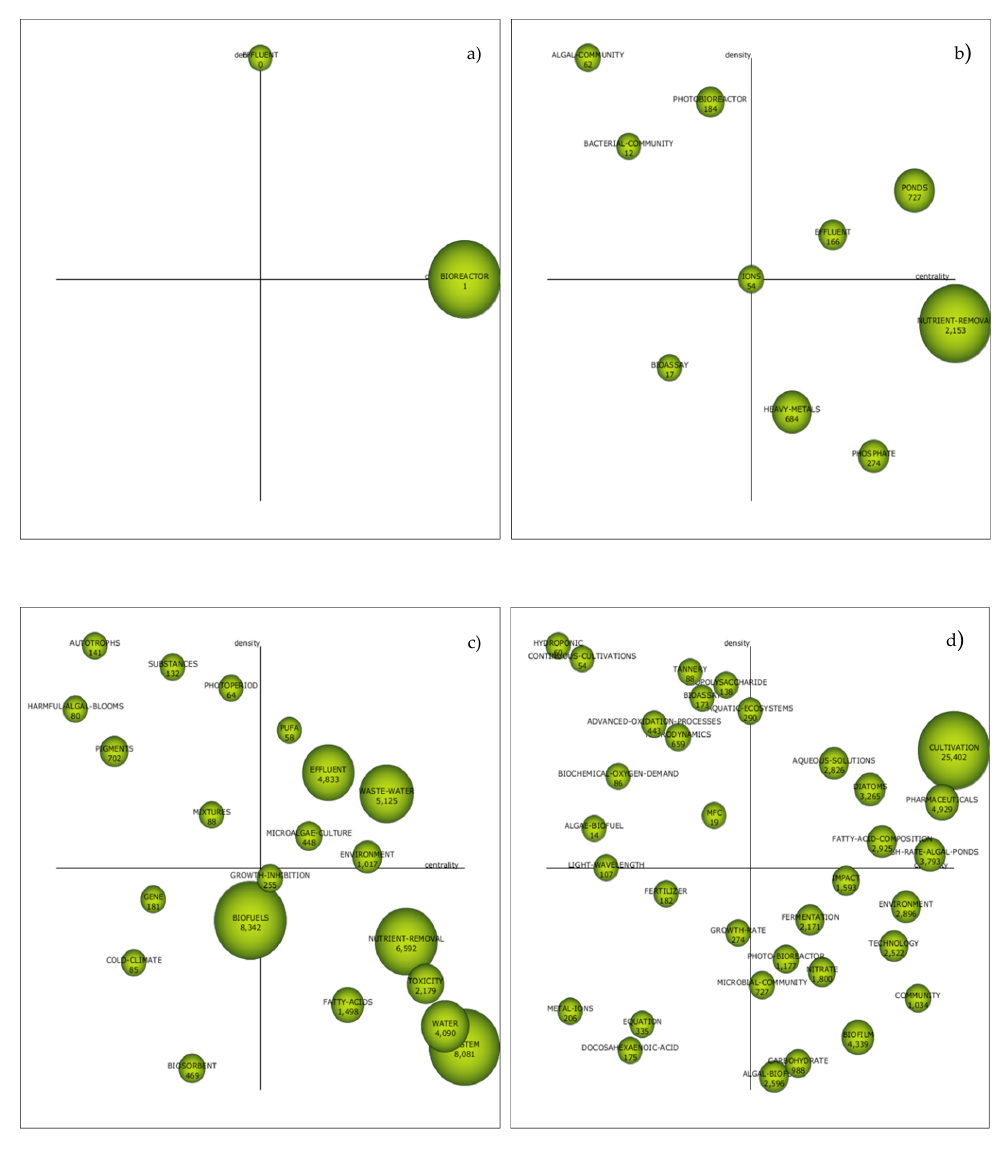
Figure 3. Strategic diagrams. ( a ) Period 1981–1990. ( b ) Period 1991–2000. ( c ) Period 2001–2010. ( d ) Period 2011–2018. (SciMAT